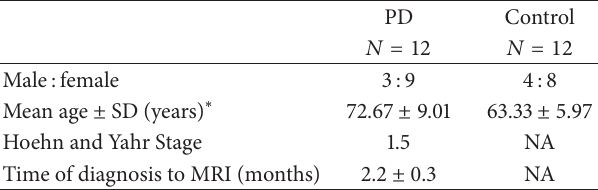
Table 1: Demographic and clinical characteristics of